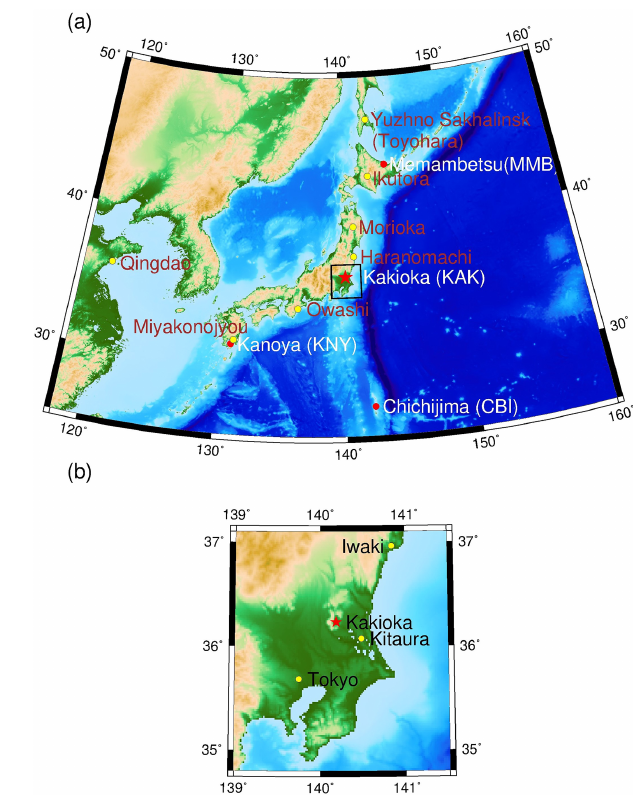
Figure 1. Map of the present (red circles) and past (yellow circles) observation sites of Kakioka Magnetic Observatory. The headquar- ters at Kakioka are marked by a red star. The map was drawn by using Generic Mapping Tools (Wessel and Smith,